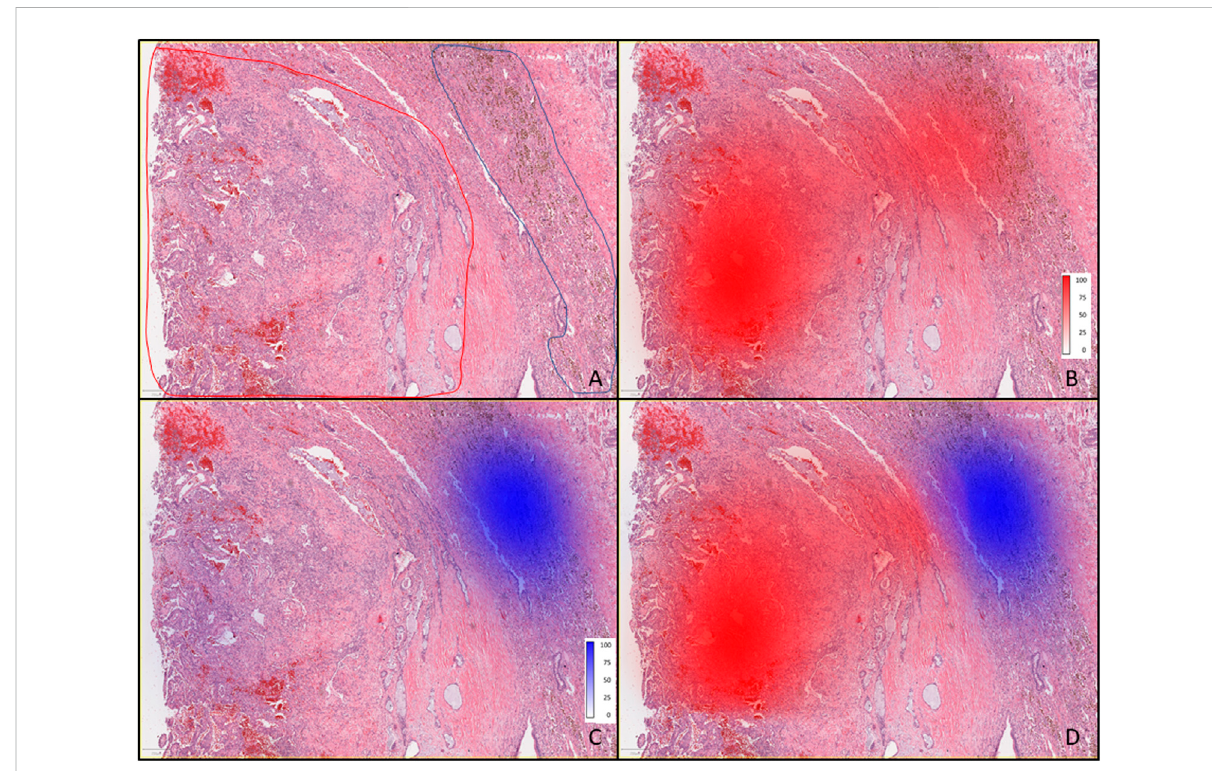
FIGURE 2 Pathomics analysis of the PSP tumor. (A) Low-power (4×) photomicrograph showing areas containing tumor (outlined red) and hemosiderin- laden macrophages (outlined blue) as annotated by the pathologist. (B) Tumor with red color density maps showing the number of cells per mm 2 as identi fi edbytheclassi fi er,andshownaspercentages(0 – 100),wherethe100%scalevaluecorrespondsto1660cellspermm 2 ,alongwithintensered coloring. (C) Tumortissuewithbluecolordensitymapsshowinghemosiderin-ladenmacrophageswherethemostintensebluecolorandscale value of 100% corresponds to 349 cells per mm 2 (as identi fi ed by the classi fi er). (D) Overlaid density maps for both cell types (same classi fi er results and color intensity scales as in (B,C)